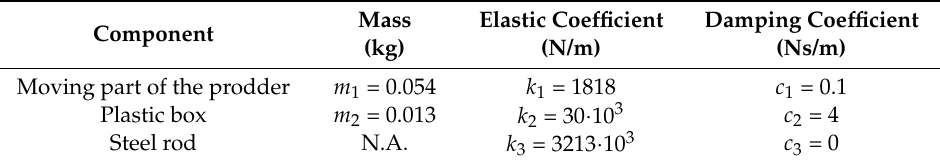
Table 1. Mechanical parameters of the lumped model.